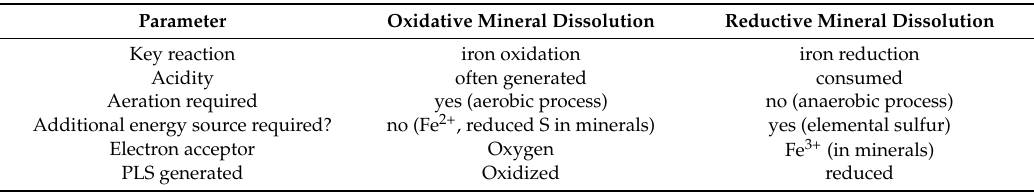
Table 1. The comparison of the operational parameters and key requirements of oxidative and reductive mineral dissolution, catalysed by acidophilic